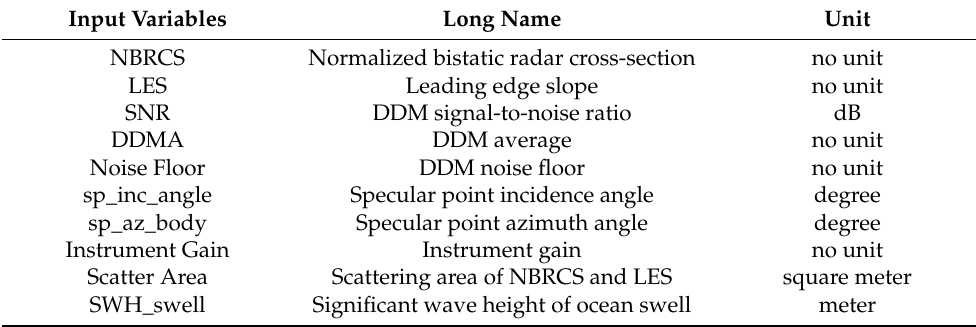
Table 1. List of input variables used in wind speed retrieval.